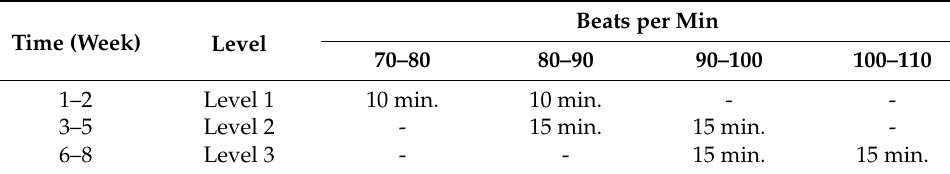
Figure 1. CONSORT flow diagram displaying cluster randomized clinical trial participant pathways through the 8 weeks study. PSME = Progressive step marching exercise. Table 1. Progressive marching exercise program